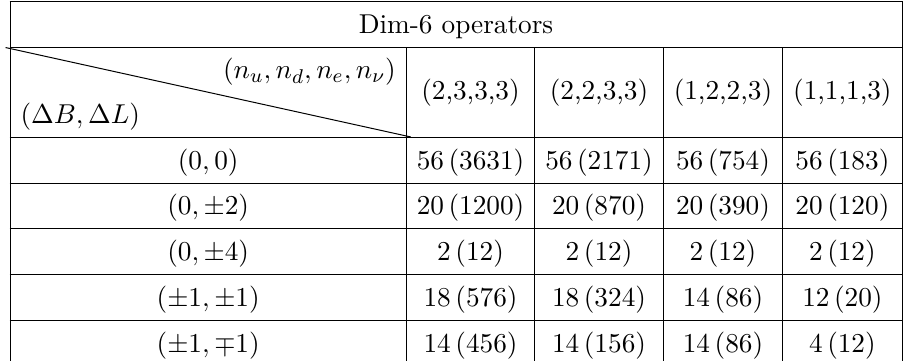
, n , n and n represent active number u d e ν = 2 and u = 3 , 2 , 1 corresponds active e